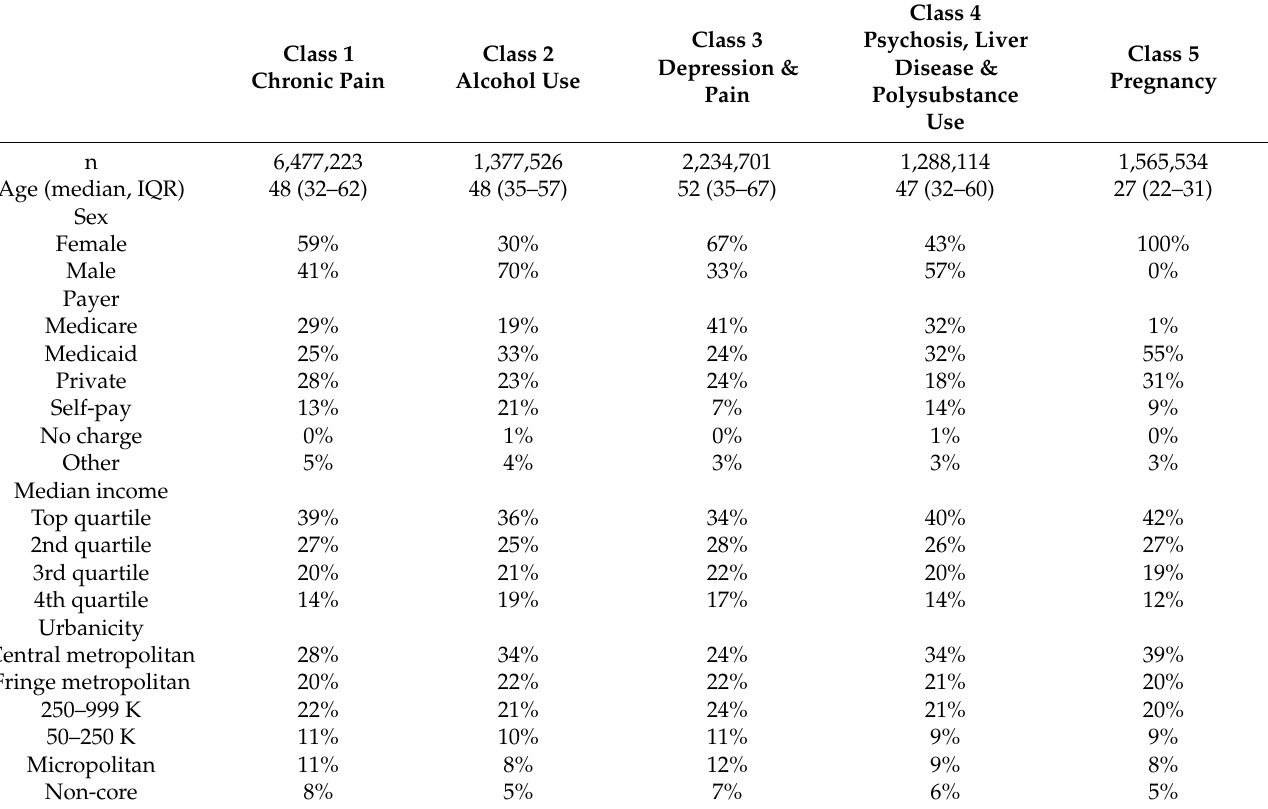
Table 3. Covariate analysis of patient characteristics by latent